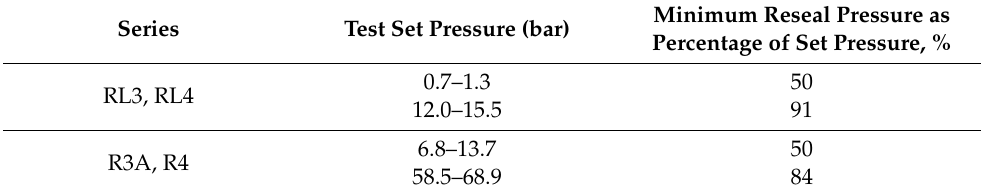
Table 2. Reseal and set pressure of relief valves. Swagelok.